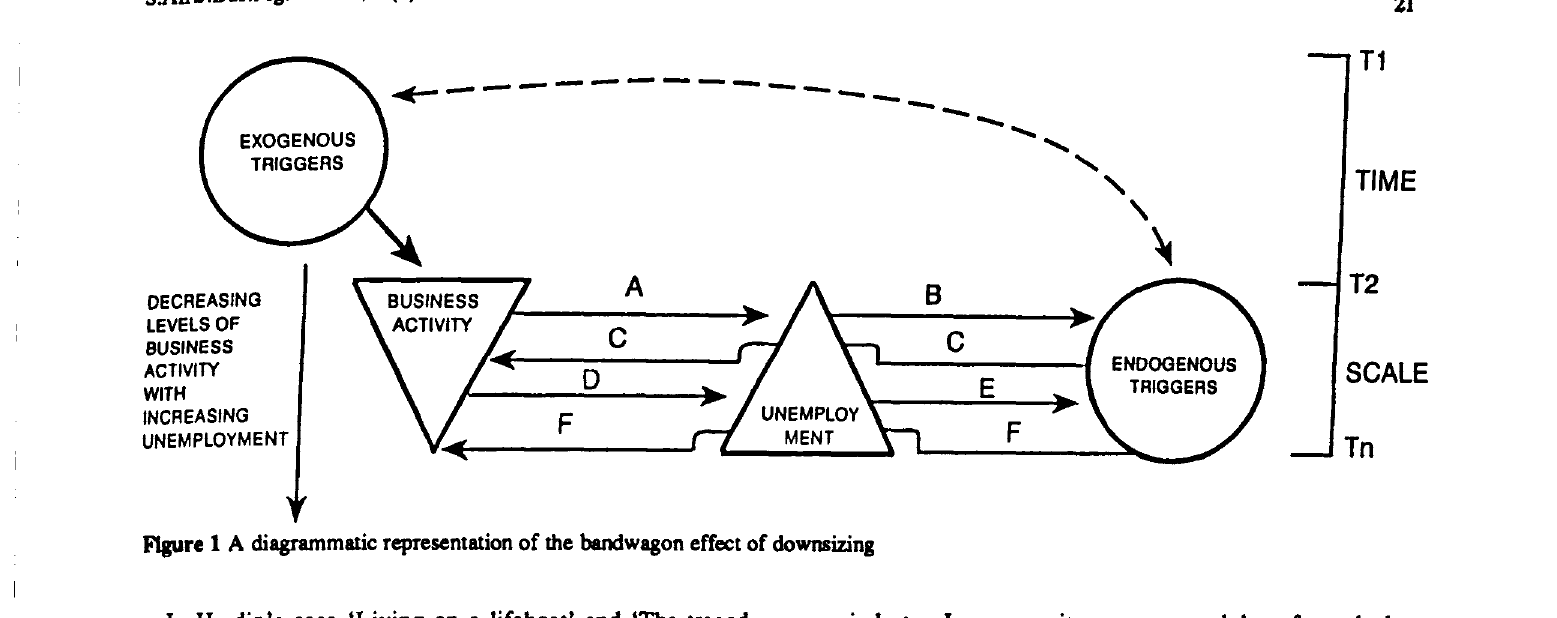
Figure 1 A diagrammatic representation of the bandwagon effect of